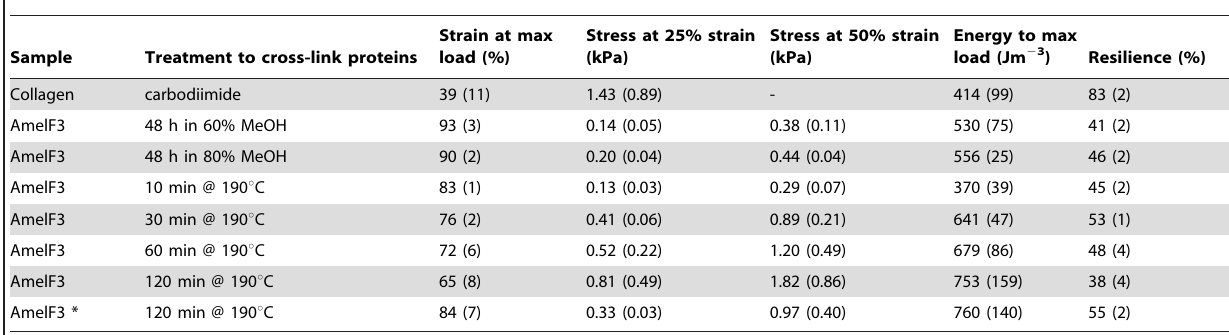
Table 3. Average values of the mechanical properties of sponges subjected to cyclic compression testing in PBS.